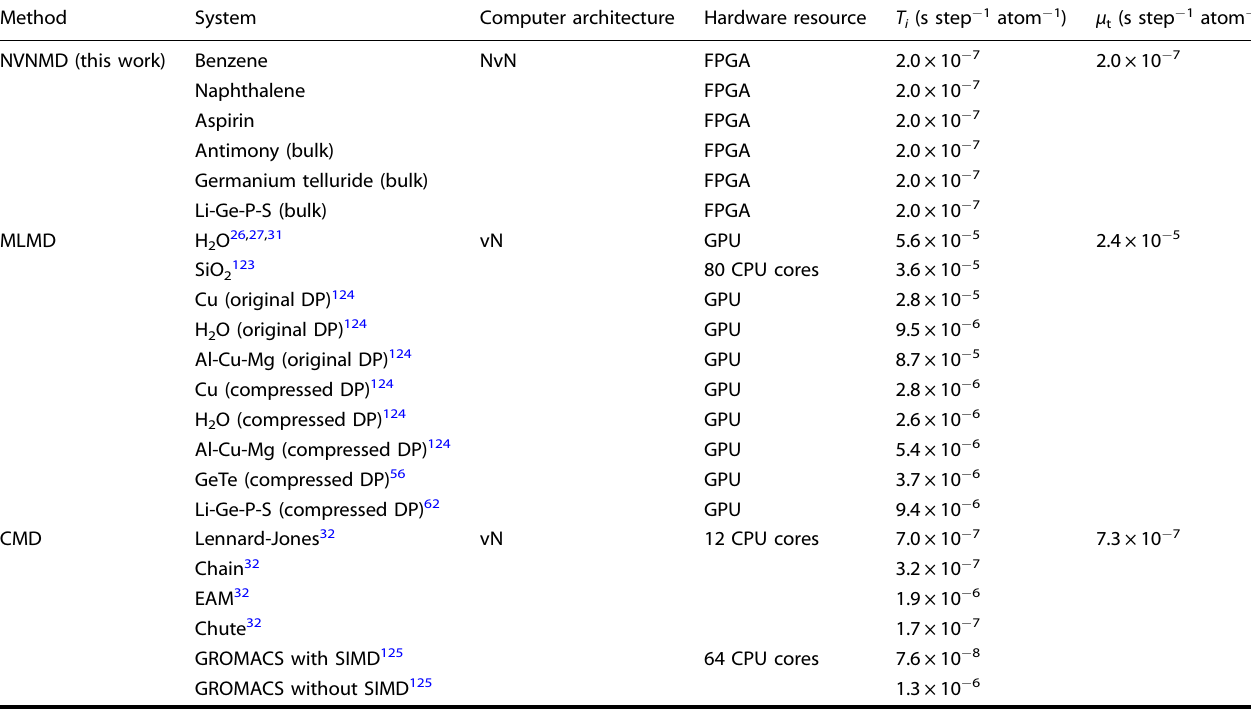
Table 5. Calculation time ef fi ciency comparison between the proposed NVNMD and the established MLMD/CMD. Method System